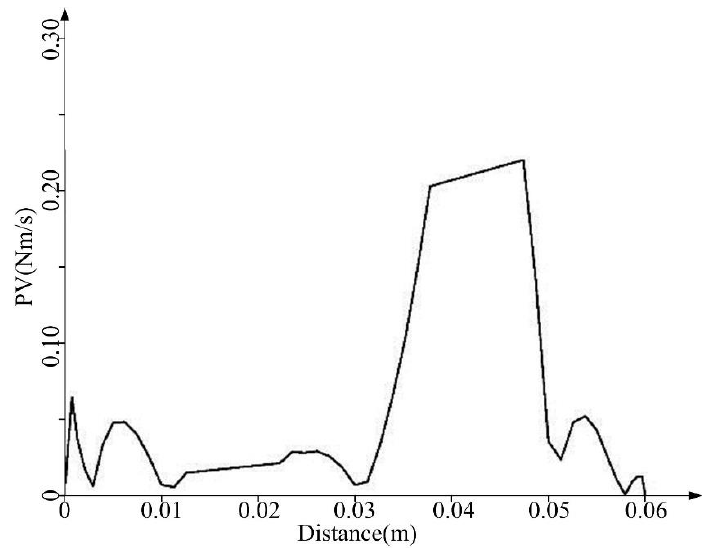
Figure 12. The product of force and velocity.